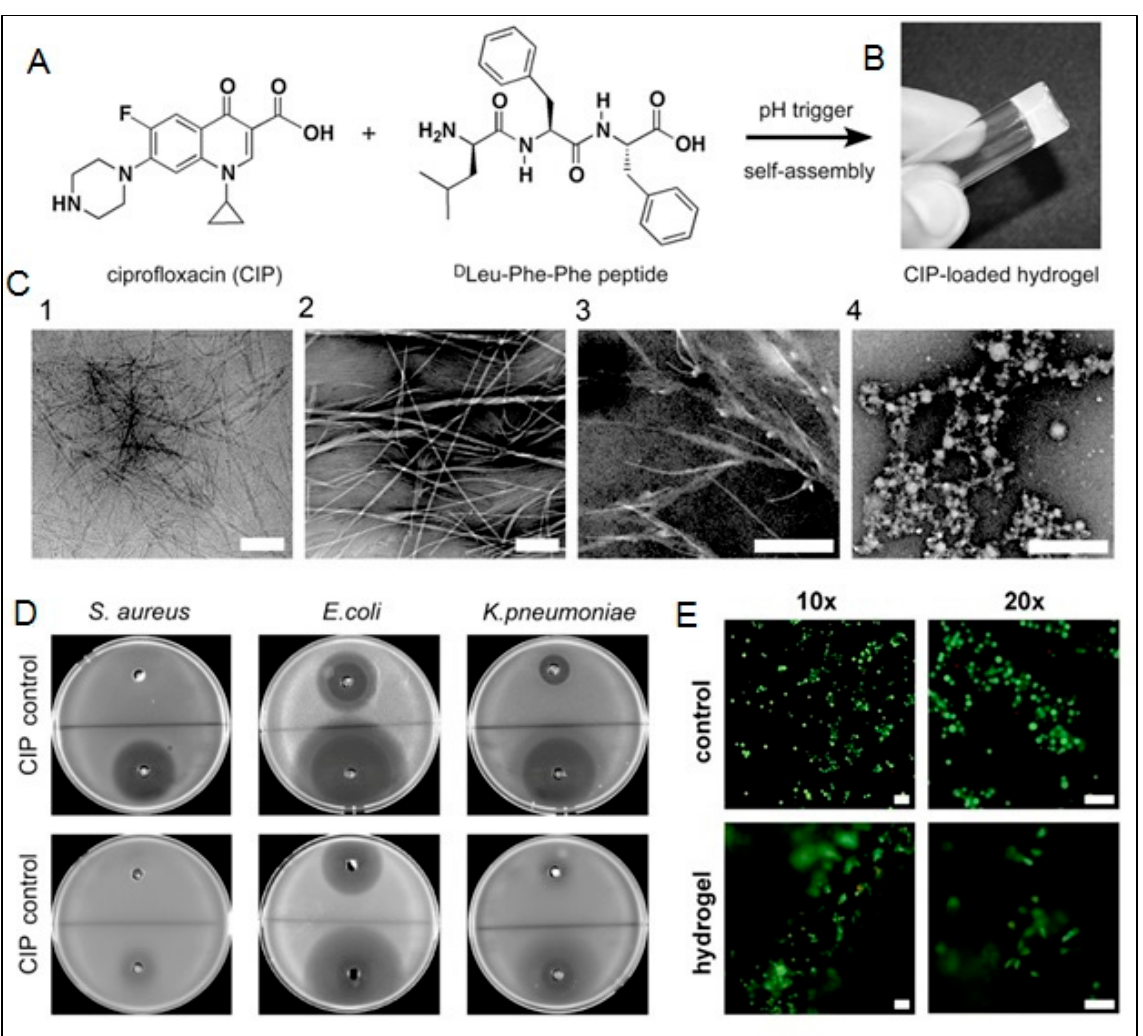
Figure 17. Design and fabrication of antimicrobial nano-hydrogel. ( A ) Chemical structure of ciprofloxacin (CIP) and tripeptide D Leu-Phe-Phe; ( B ) hydrogel formation by self-assembly with pH change; ( C ) Cryo-TEM ( C1 ) and TEM ( C2 – C4 ) images of hydrogels loaded by CIP ( C1 , C3 , C4 ) and tripeptide ( C2 ) (Scale bar: 200 nm). ( D ) Microgel well diffusion assay measured the antibacterial efficacy of CIP-gel on Staphylococcus aureus , Escherichia coli, and Klebsiella pneumonia at low ( top ) and high ( bottom ) bacterial densities; ( E ) Live/dead assay for L929 fibroblast cultures on hydrogel or plastic used as control after three days (Scale bar: 50 μ m). Reprinted with permission from Ref. [310], Copyright 2013,